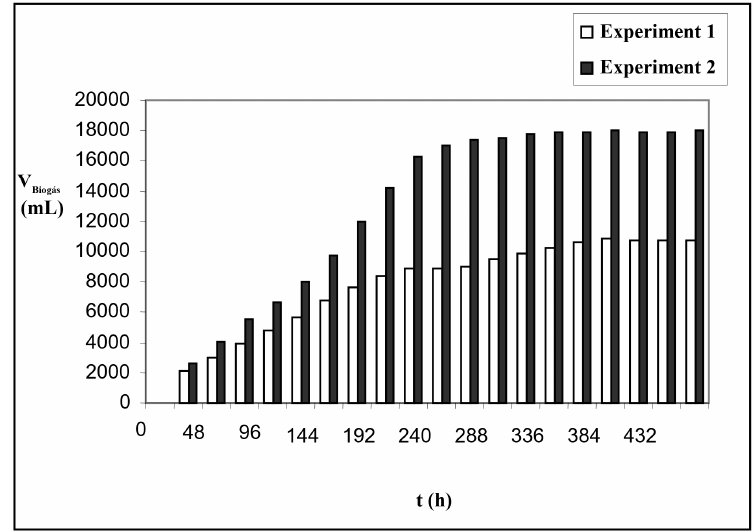
Figure 4. Biogas production.